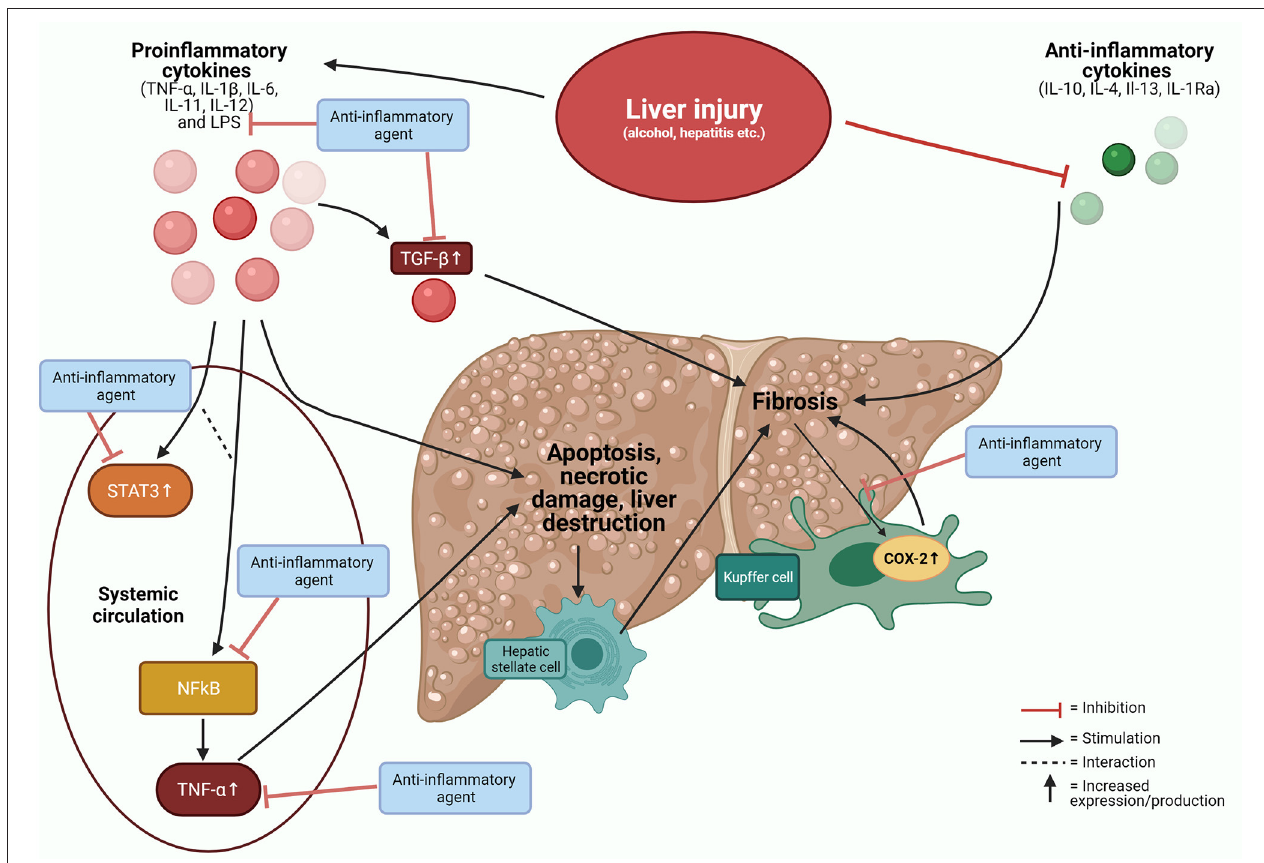
FIGURE 2 | Cytokines in liver disease. Inflammatory responses on various liver injuries and potential targets for anti-inflammatory agents. COX-2, cyclooxygenase − 2; IL, interleukin; LPS, lipopolysaccharide; NFkB, nuclear factor-kB; STAT3, signal transducer and activator 3; TGF, transforming growth factor; TNF, tumour necrosis